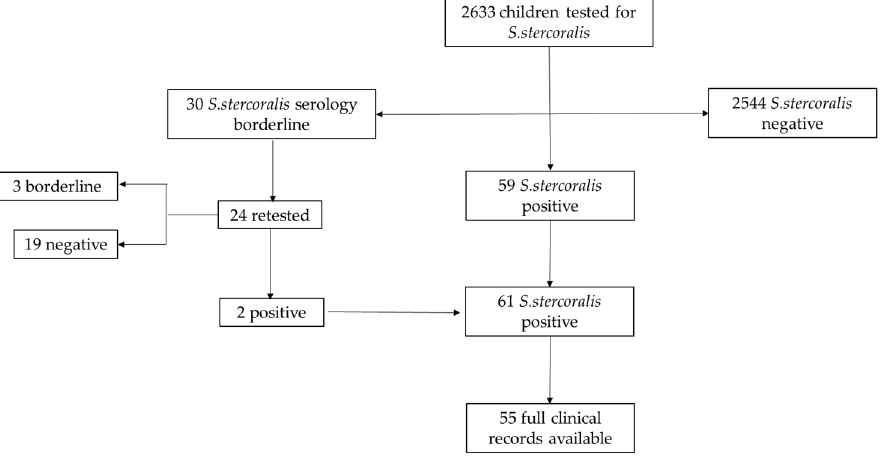
Figure 1. Flow chart of patients’ selection.